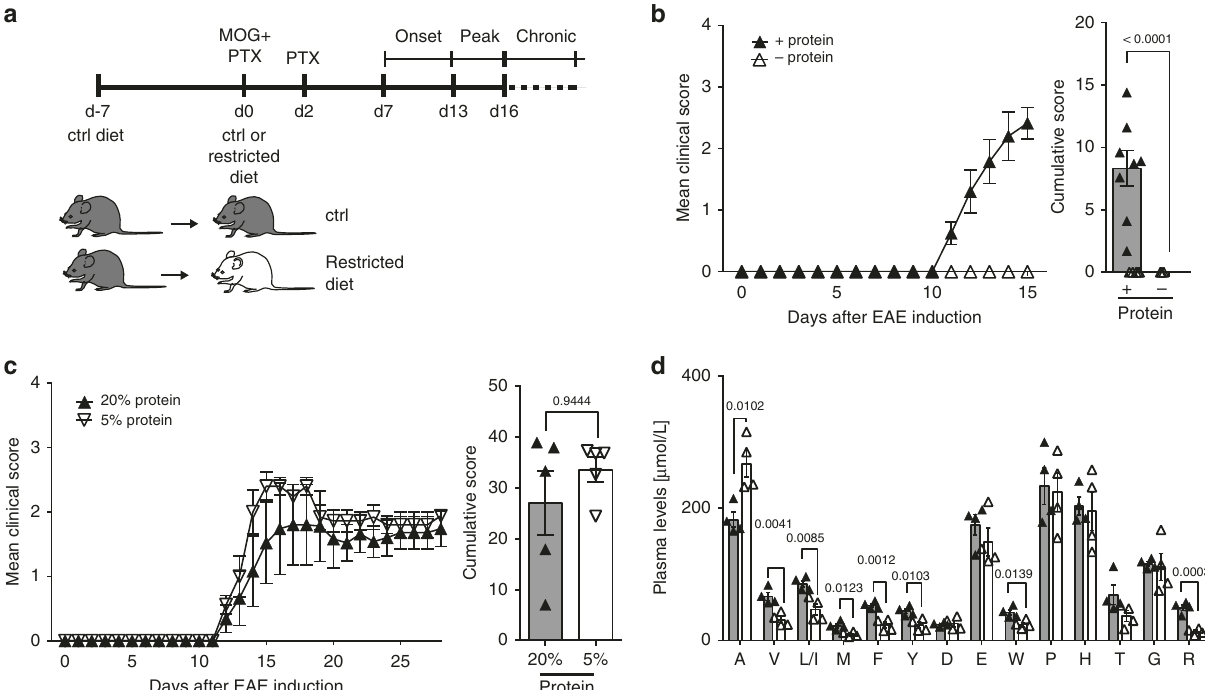
Fig. 1 DPR prevents EAE induction. a Schematic representation of experimental procedure. b Mean clinical EAE scores and cumulative scores ( + protein: n = 8, − protein: n = 10). c Mean clinical EAE scores and cumulative scores (20% protein: n = 5, 5% protein: n = 5). d Plasma amino acid concentrations of mice from b ( n = 4). Statistics: Mann – Whitney U -test for b , c ; unpaired two-tailed Student ’ s t -test for d . Each dot represents one individual mouse. Data are presented as mean ± SEM. Source data are provided as a Source Data fi